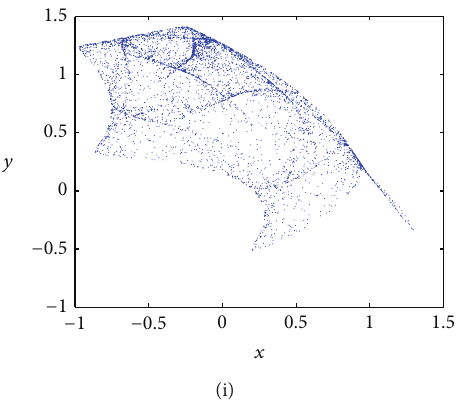
Figure 13: Phase portraits corresponding to Figure 12: (a) 𝑒 = 0.8234 , (b) 𝑒 = 0.934 , (c) 𝑒 = 0.954 , (d) 𝑒 = 0.957 , (e) 𝑒 = 0.959 , (f) 𝑒 = 0.9725 , (g) 𝑒 = 0.9901 , (h) 𝑒 = 1.016 , and (i) 𝑒 = 1.05